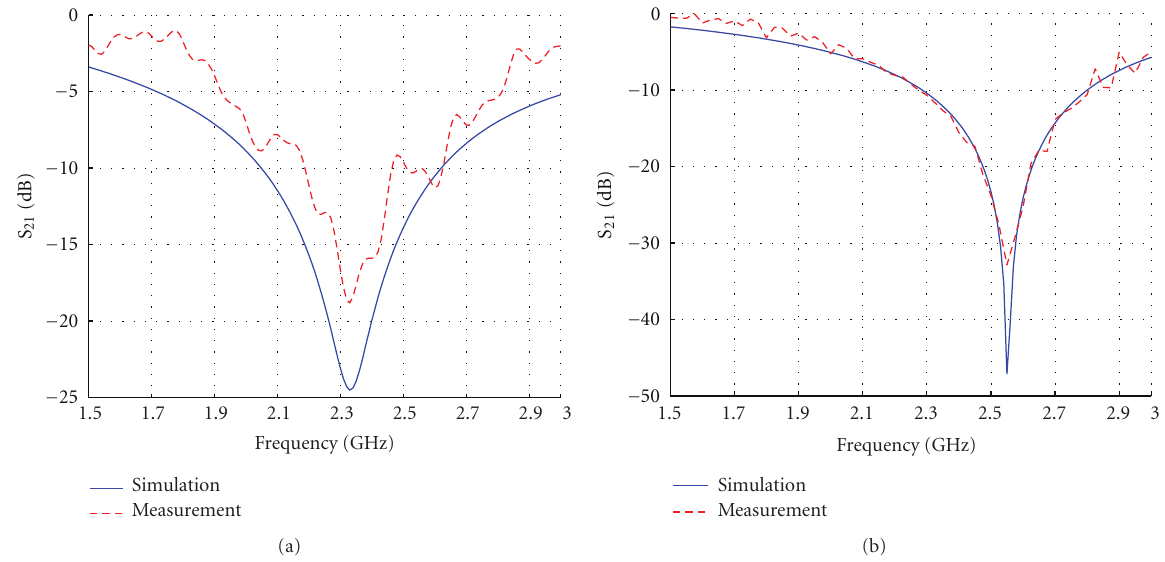
Figure 2: Simulation and measurement of S 21 parameter for the open stub on denim (a) and on felt (b).